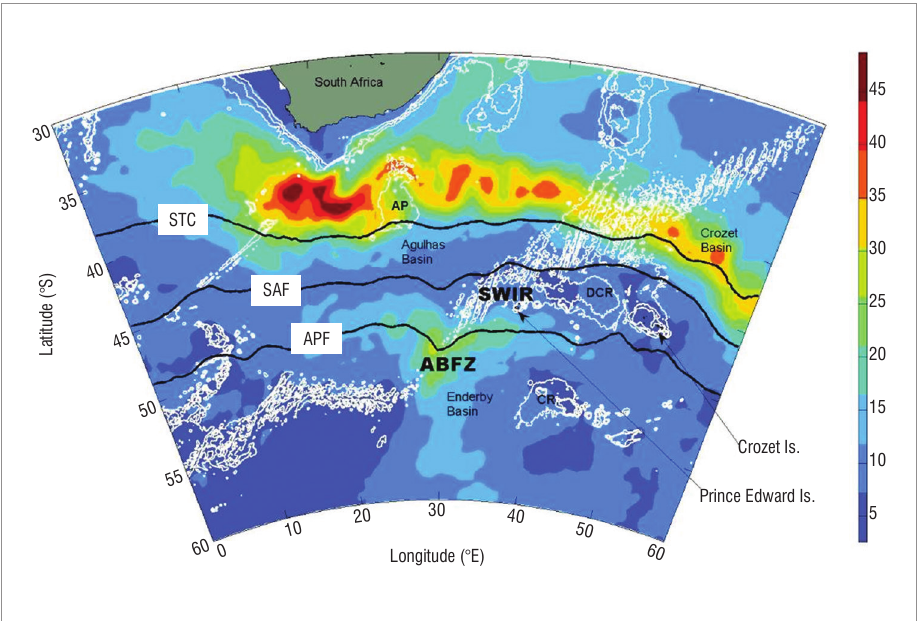
Source: Figure courtesy of Durgadoo et al. 10